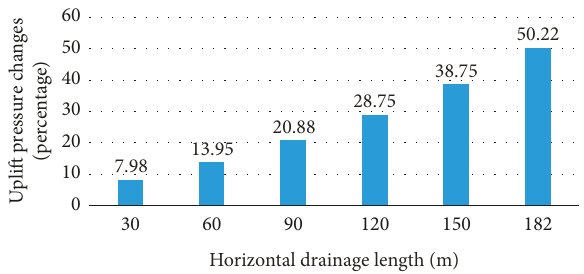
Figure 13: Percentage of changes in average uplift pressure.